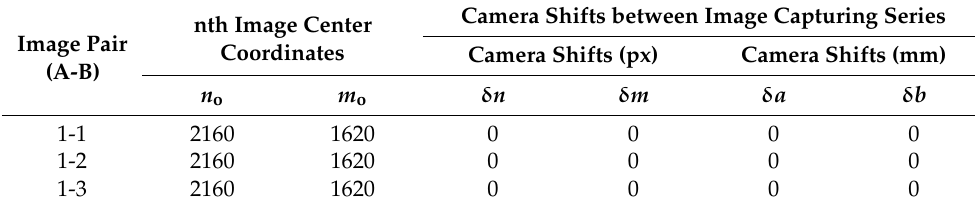
Table 3. The results of camera shift determination during image capturing.